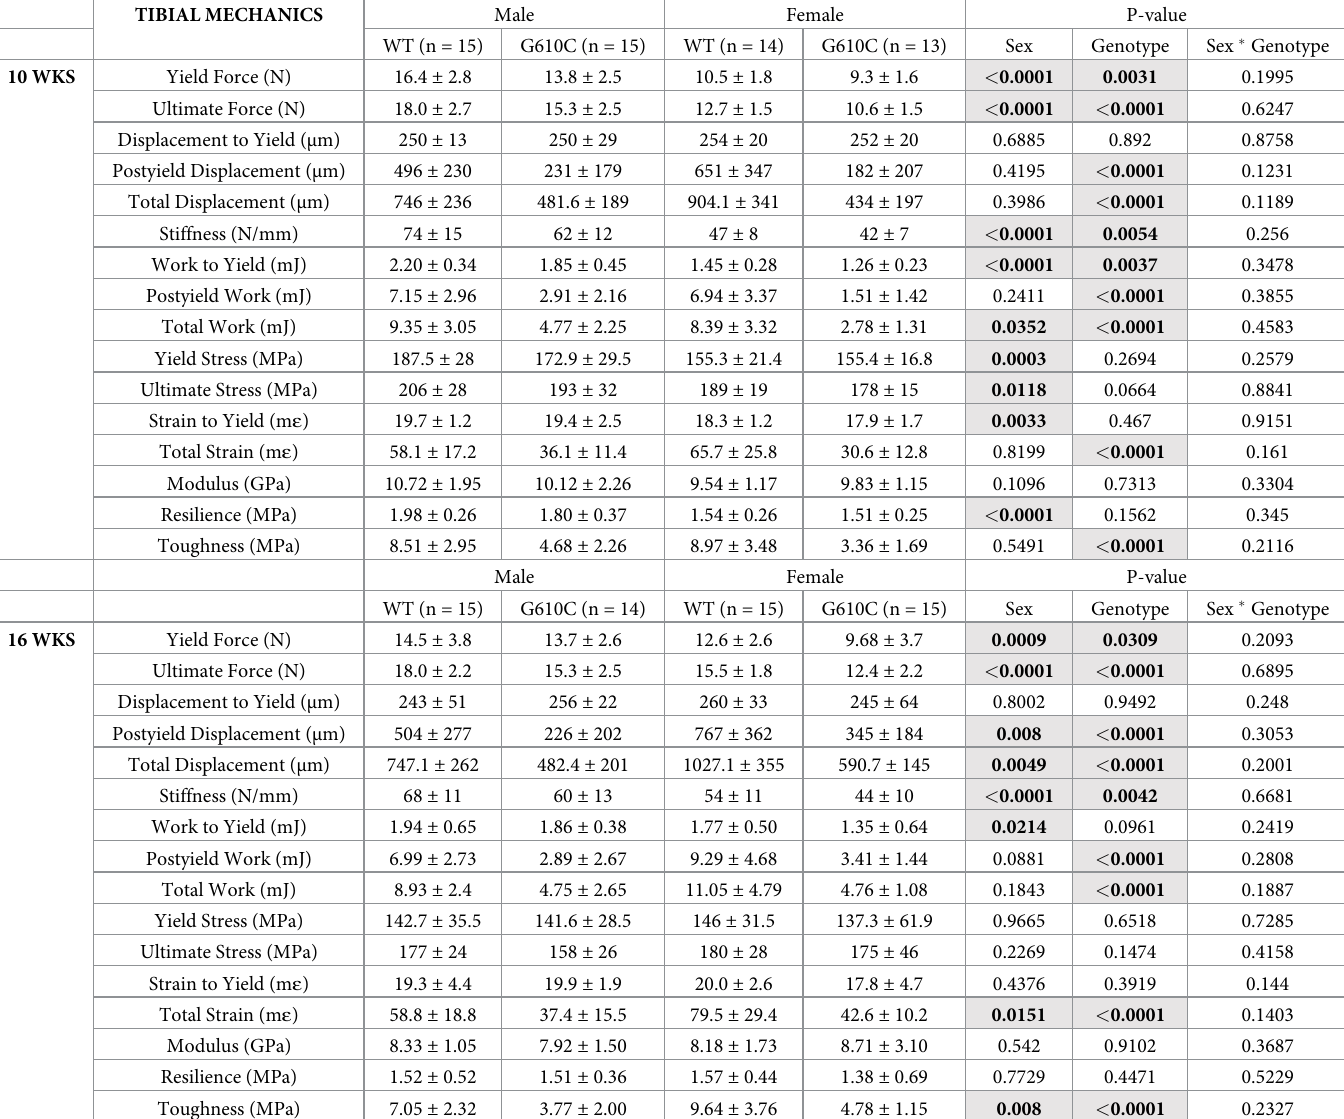
Table 6. Tibia mechanical properties at 10 and 16 weeks, with p-values from 2-way ANOVA. TIBIAL